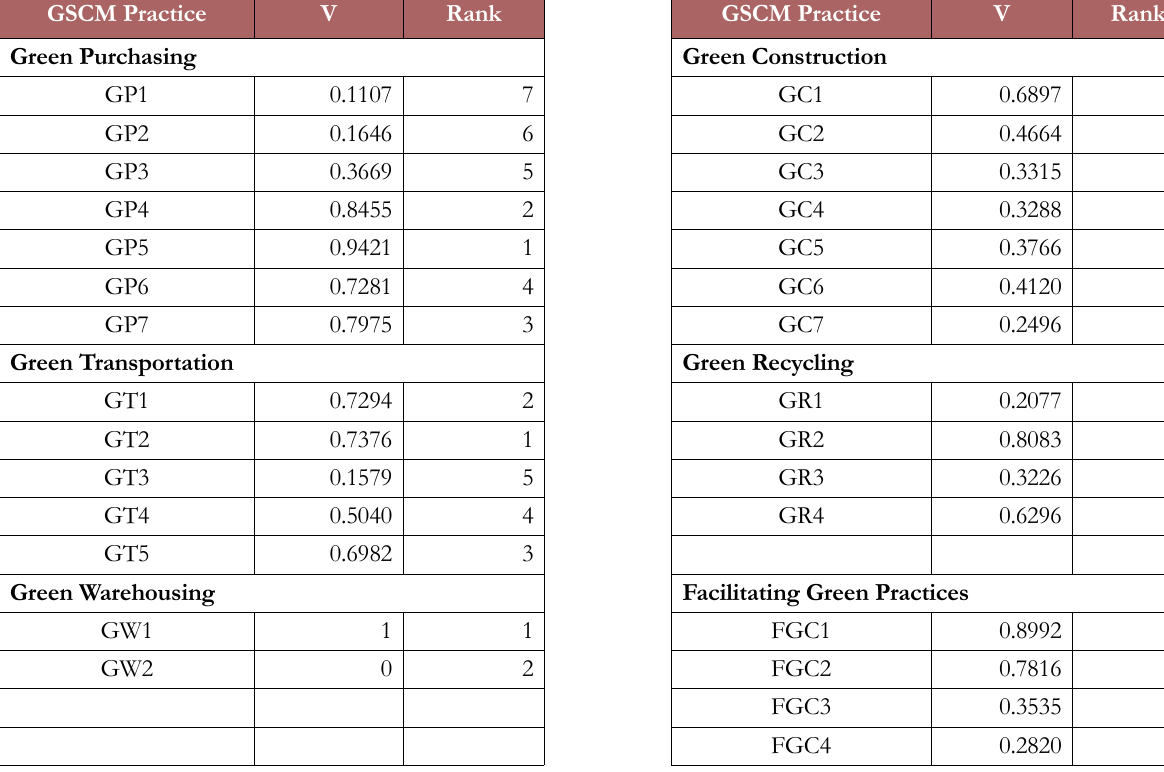
Table 8. Rankings of GSCM